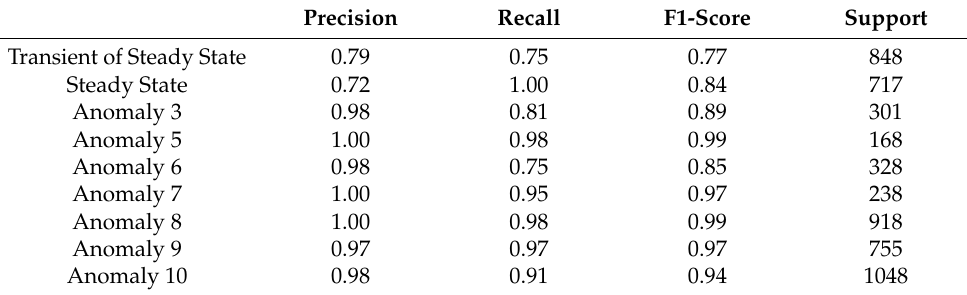
Table 5. Classification report of the level 3 anomalies.